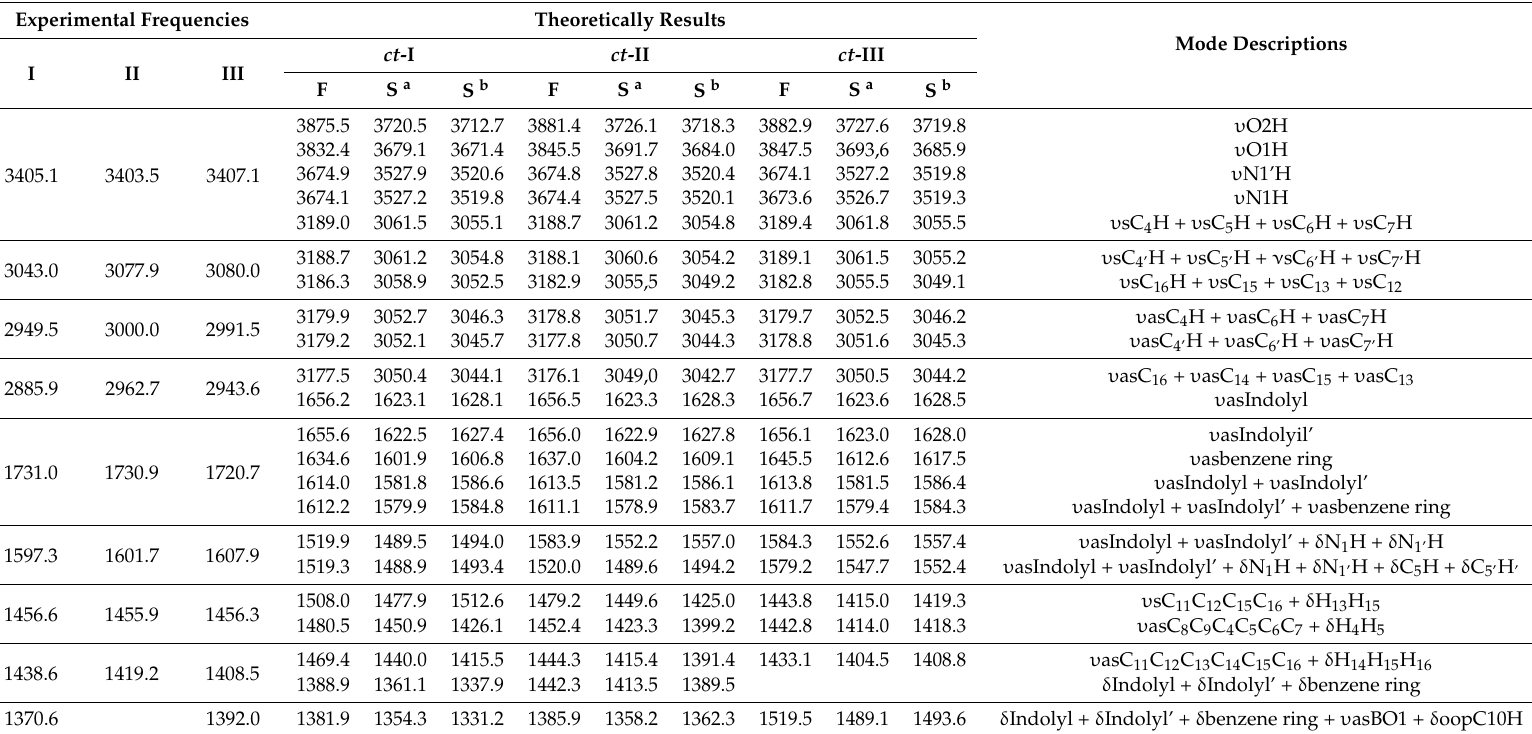
Table 8. Experimental and theoretical infrared frequencies for the conformer ct to I – III and their approximate mode description. Experimental